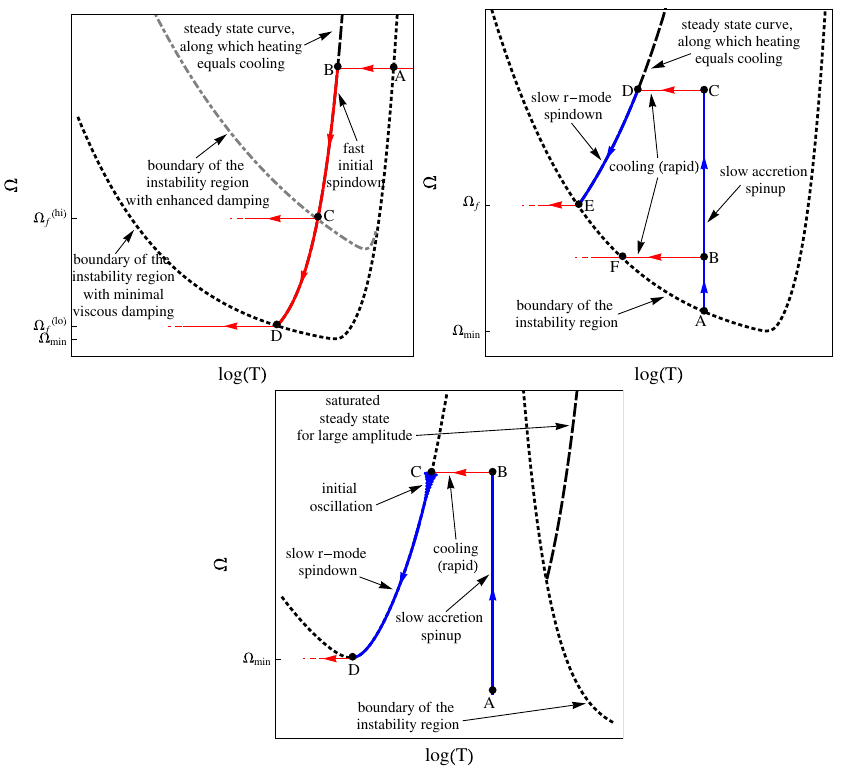
Fig. 21 Different scenarios in which the r-mode instability can generate gravitational waves in the angular velocity ( Ω ) - temperature ( T ) plane. Top left panel: Spindown of nascent sources; Top right panel: Pulsar recyclinginLMXBsandspindownofmillisecondpulsars;Lowerpanel:Recyclingandspindowninsources with increased damping. Each time the evolution goes through or lies at the boundary of the instability region (region within the dotted lines) gravitational wave emission is switched on. (Image reproduced with permission from Kokkotas and Schwenzer 2016, copyright by SIF/Springer)